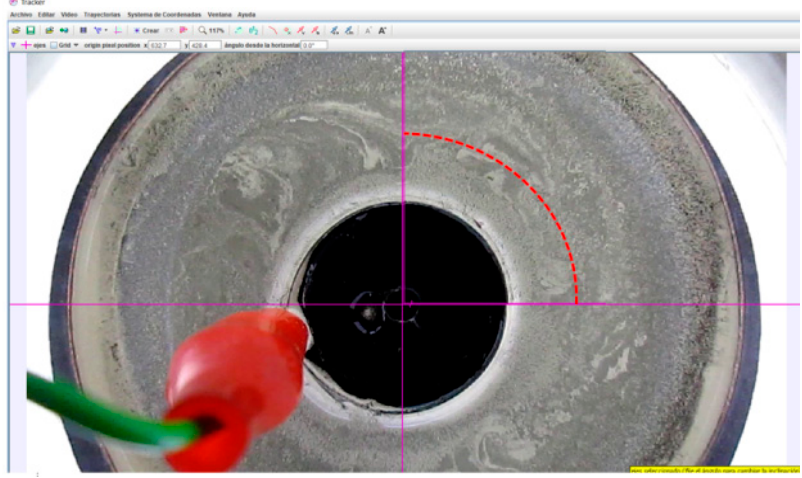
Figure 14. ¼ turn tracker analysis of selected particle at r = 26.76 mm from the center (8 mm from the internal cylinder) in the path of the annular duct where the maximum flow velocity is present for experiment C.